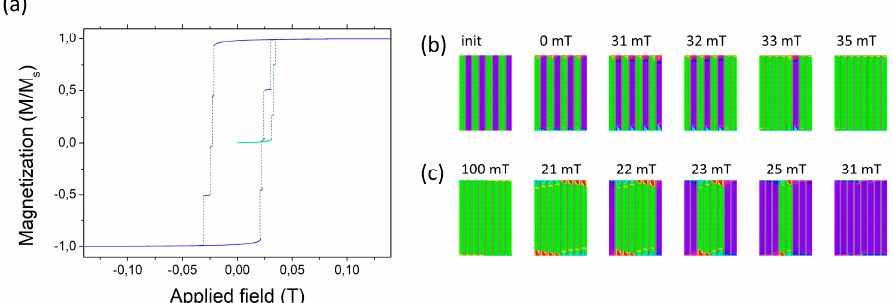
Figure 10. ( a ) Hysteresis loop for the system of eight stripes. ( b ) The configuration sequence when starting from AF and ( c ) the configuration sequence when starting from FM. The AF configurations are equivalent, no distinction AFu and AFd.